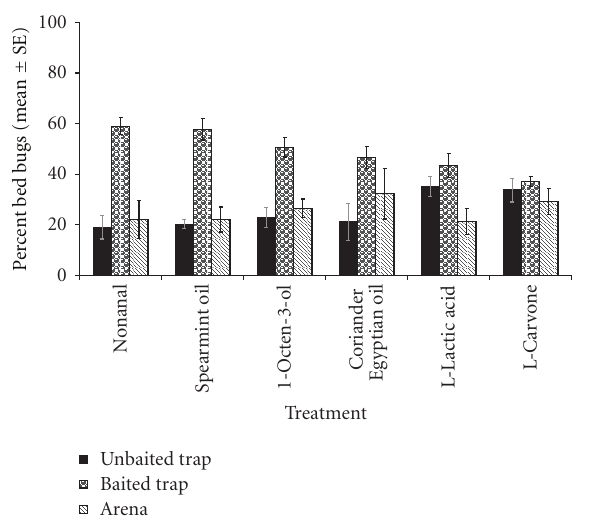
Figure 5: Attractiveness of chemical lures to bed bugs in two-choice bioassays. Figure 6: Attractiveness of a lure mixture compared with single